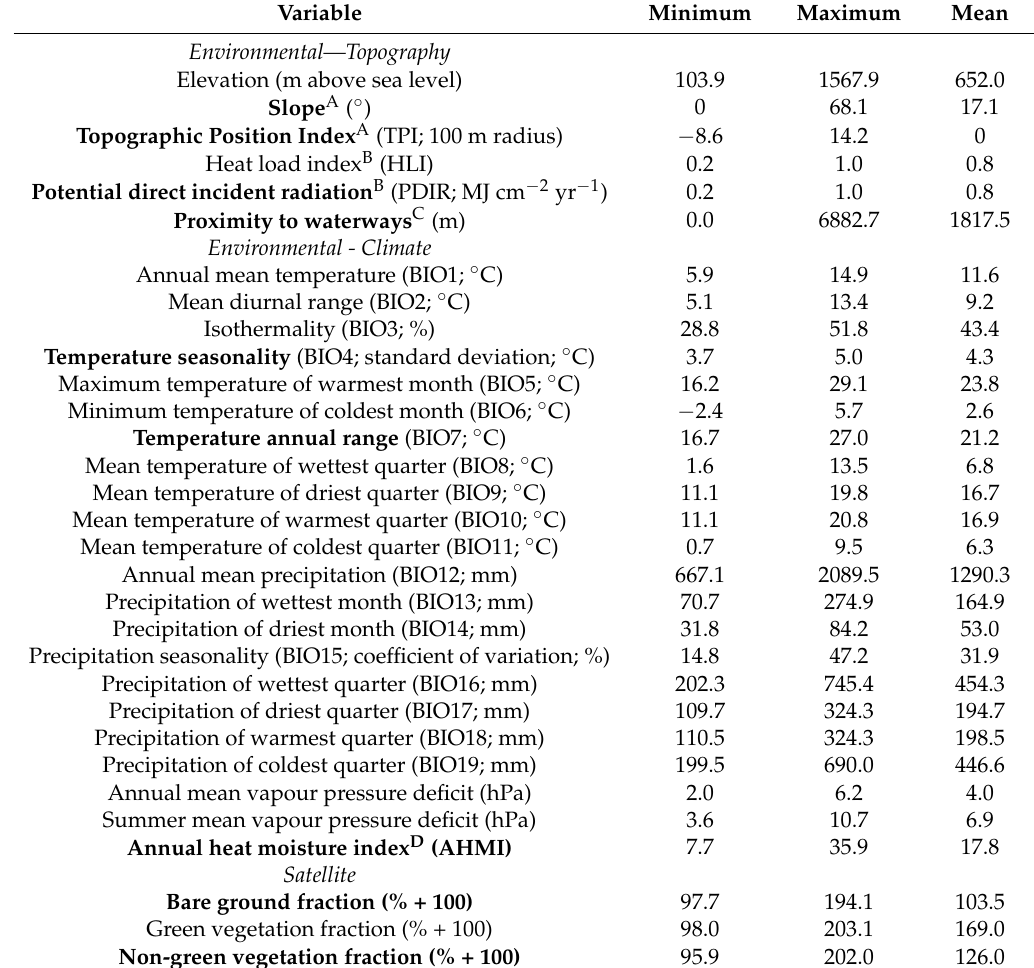
Table 2. Environmental and satellite variables for the Central Highlands region (bold variables were included as potential predictors in species distribution models, non-bold variables were excluded based on strong correlations, r ≥ |0.7|, with included variables). Maximum, minimum and mean values are provided for each variable within the lidar acquisition